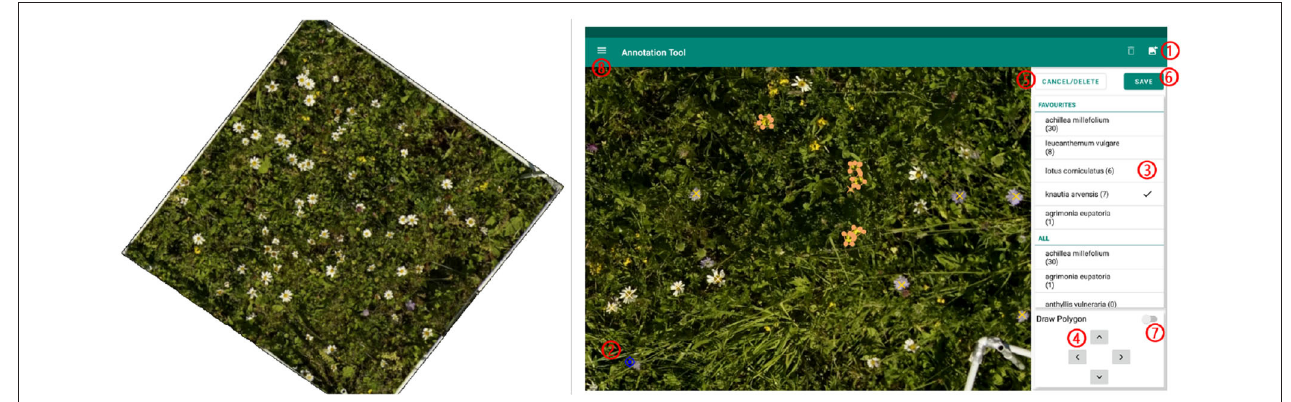
FIGURE 2 | (Left) Example of area extracted from a sample square to be annotated. (Right) Screenshot of the FieldAnnotator during the annotation process. The numbers highlight the controles of the FieldAnnotator. For a detailed description please refer to Supplementary Section A.1 .